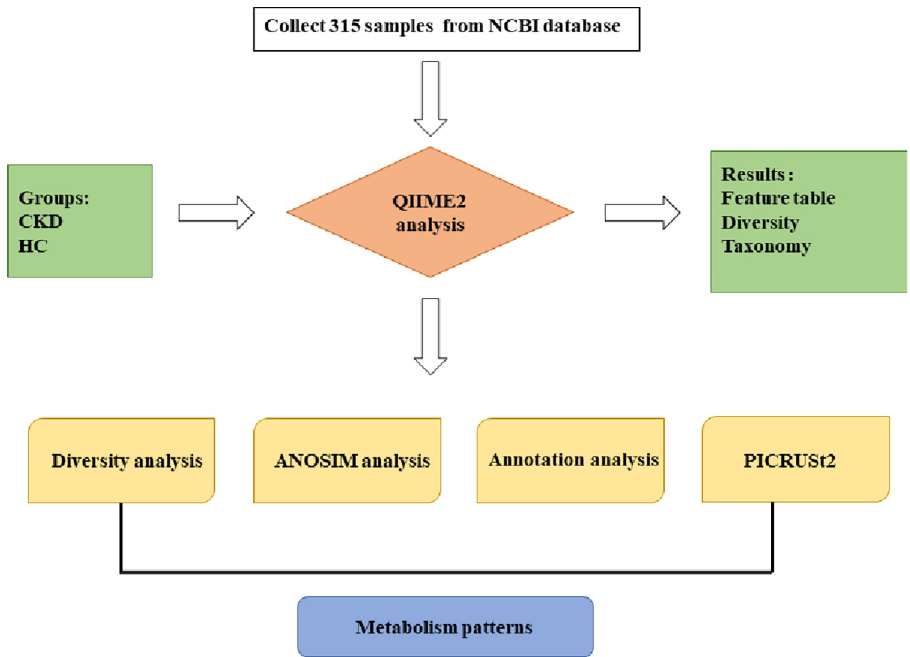
Fig 1. The schematic representation of bioinformatic